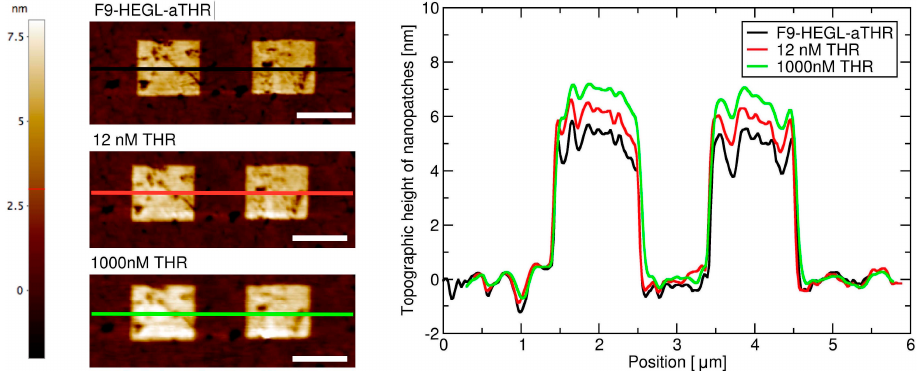
Figure 4. Images of the nanopatches on the gold surface ( left , bar 1 μ m) and their topographic profiles ( right ). Black: F9-HEGL-aTHR aptamer immobilization; red: THR 12 nM incubation; and green: THR 1000 nM incubation.